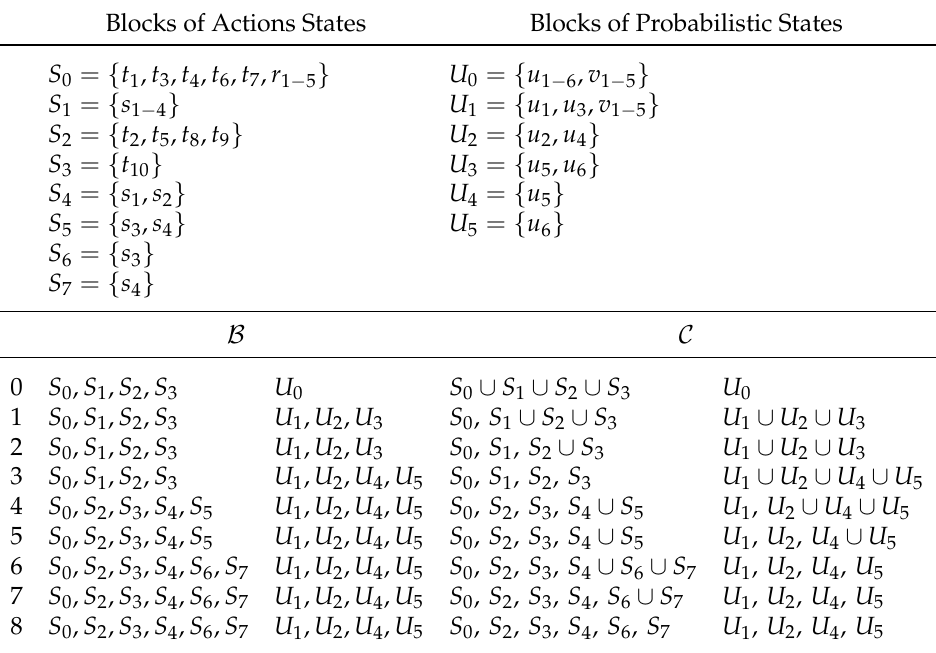
Table 1. The generated partitions for the PLTS of Example 1. Blocks of Actions